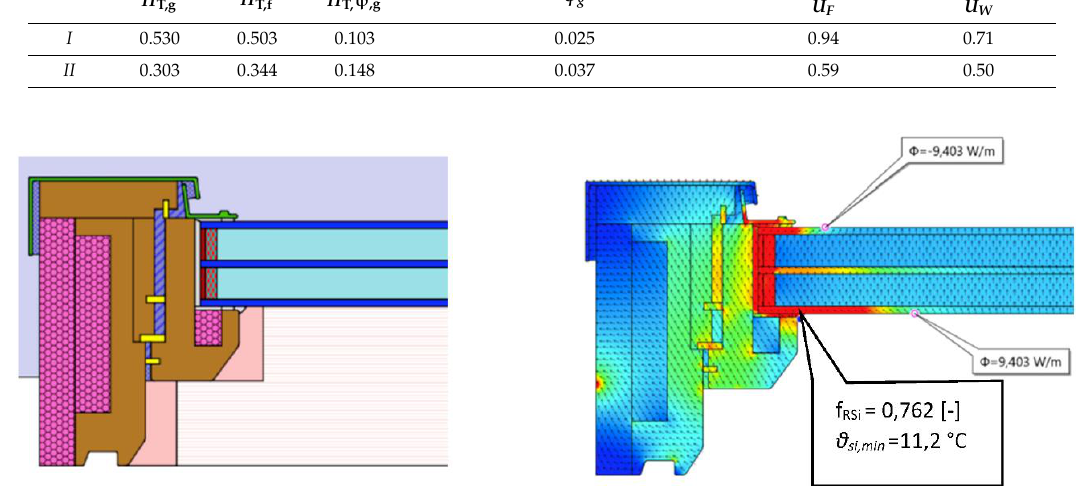
Figure 13. Schematic cross-section of the window variant, I , with triple glazing ( left ) and calculated heat flux distribution ( right ).